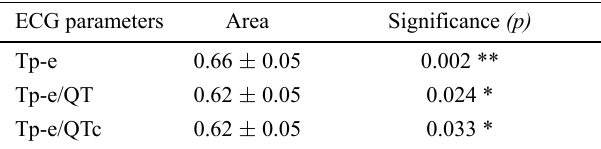
Table 3. Area under the receiver operator characteristic (ROC) curves in ECG